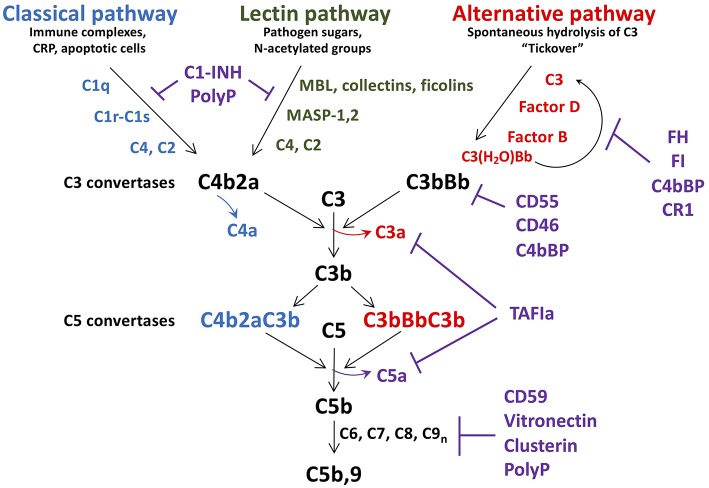
Schematic of complement activation and regulation. Complement activation occurs via the classical, lectin, or alternative pathways, triggered by exposure of C1q, MBL, collectins and ficolins, to danger signals. The alternative pathway is constitutively active, due to spontaneous hydrolysis of C3 to C3(H2O). All pathways converge to form C3 convertases, with release of C4a, and C3a. As C3b is further generated, C5 convertases C4bBbC3b, and C3bBbC3b are formed, resulting in release of the potent anaphylatoxin C5a, in concert with C5b. C5b is the initial factor required for assembly of the C5b-9 membrane attack complex which induces lysis/damage to the cellular target. Tight regulation is achieved at multiple levels by soluble and membrane associated factors (C1-INH, FH, FI, CD55, CD46, polyphosphate (polyP), CD59, clusterin, and vitronectin). C1-INH, C1 esterase inhibitor; MBL, mannose binding lectin; CRP, C-reactive protein; MASP, MBL associated serine protease; FH, factor H; FI, factor I; TAFIa, activated thrombin activatable fibrinolysis inhibitor.